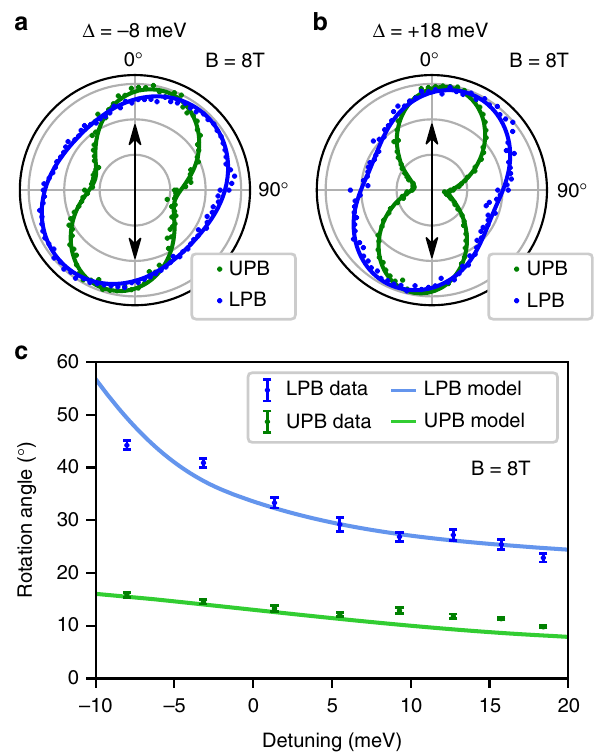
Fig. 5 Coherent control of the exciton-polariton valley pseudospin vector under a magnetic fi eld. a , b Polariton intensity as a function of the linear polarization angle in detection under a magnetic fi eld of B = 8 T in the Faraday geometry, for detunings of a Δ = − 8 meV and b Δ = + 18 meV. The black arrows indicate the injected linear polarization. c The rotation angle of the linear polarization plane of polariton PL as a function of the exciton-photon detuning at B = 8 T, under vertical linear excitation. The data for LPB (UPB) are shown in blue (green). Errorbars correspond to the error in fi tting the detection angle dependent intensity data at each detuning value. Overlaid curves are simulated rotation angles, calculated using the model described in the main